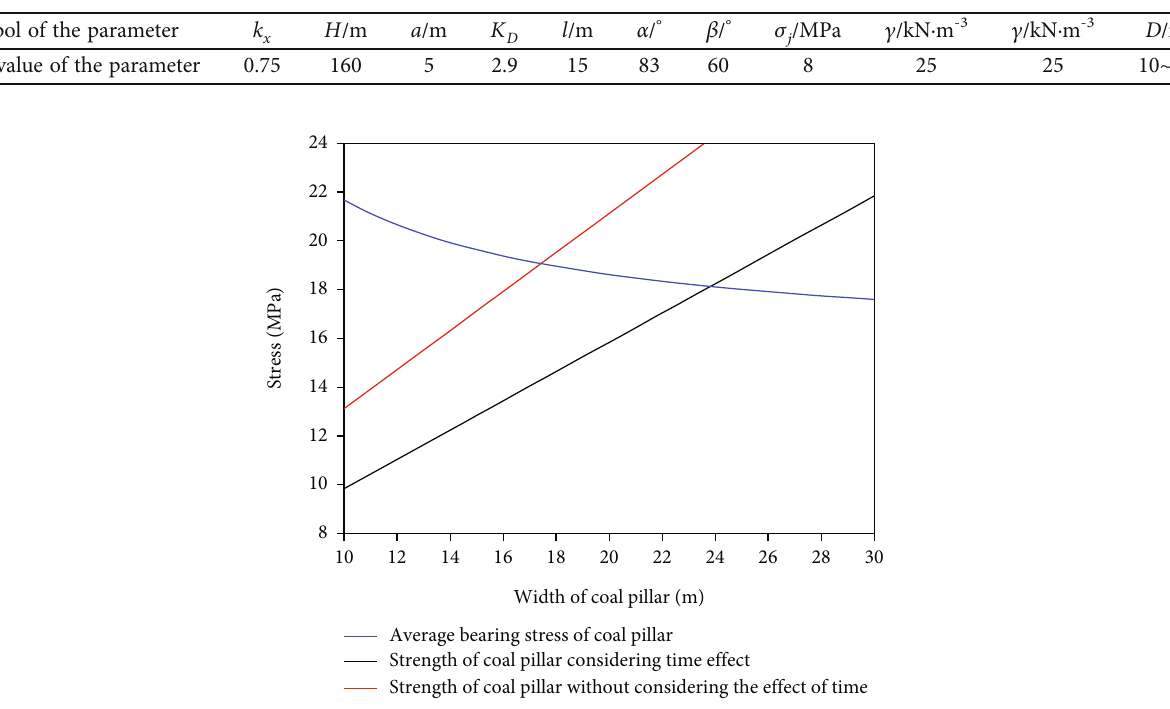
Table 2: Mechanical parameters of stopping mining coal pillar.